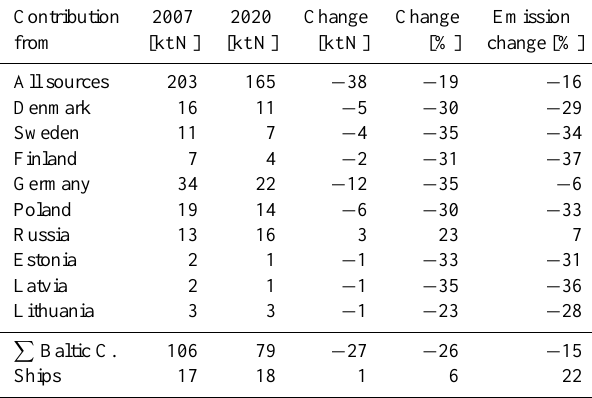
Table 3. A country allocation table with the predicted contributions (in ktonnesNyr − 1 ) from different source regions/types to the total nitrogen deposition to the Baltic Sea. The change from 2007 to 2020 is given both as k tonnes N and in percent [%]. The changes in nitrogen emissions are also given (taken from Table 1).